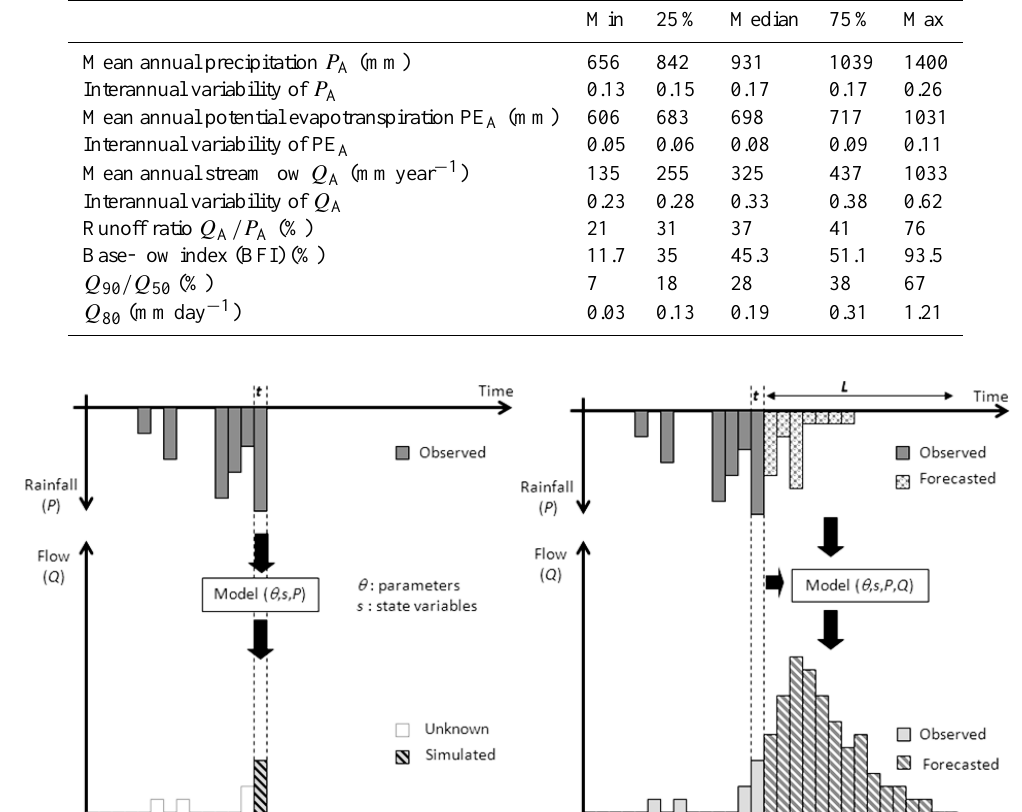
SAFRAN variables were first aggregated at the catchment scale by simple